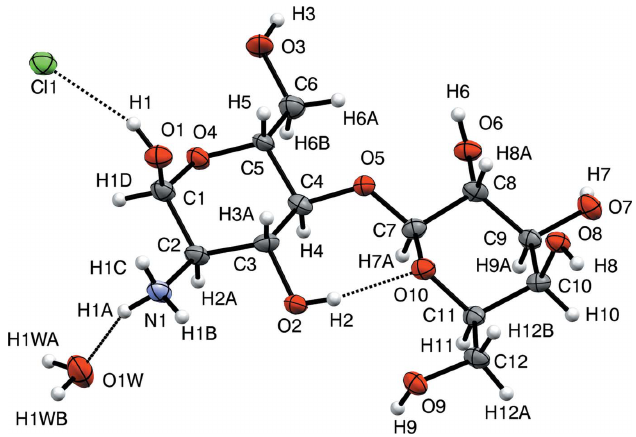
Figure 1 Atomic numbering and displacement ellipsoids at the 50% probability level for ( I ). Hydrogen bonds are shown as dotted lines.